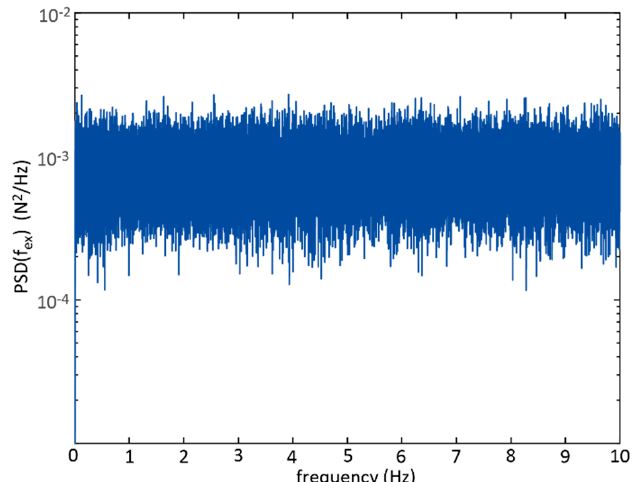
Figure 3. Power Spectral Density estimate via Welch’s method of white noise excitation force (close-up of frequency range 0 Hz to 10 Hz).